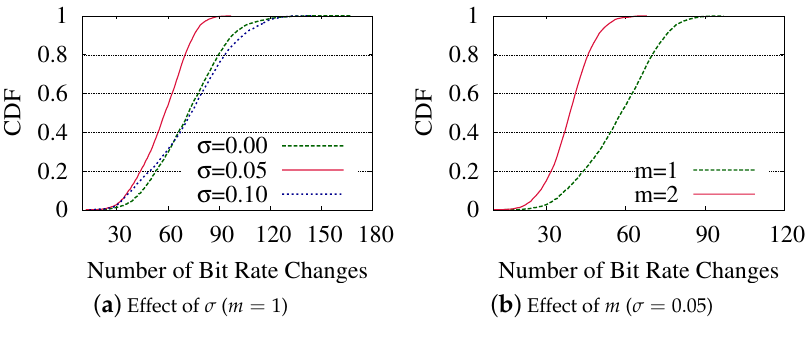
Figure 3. Effect of σ and m